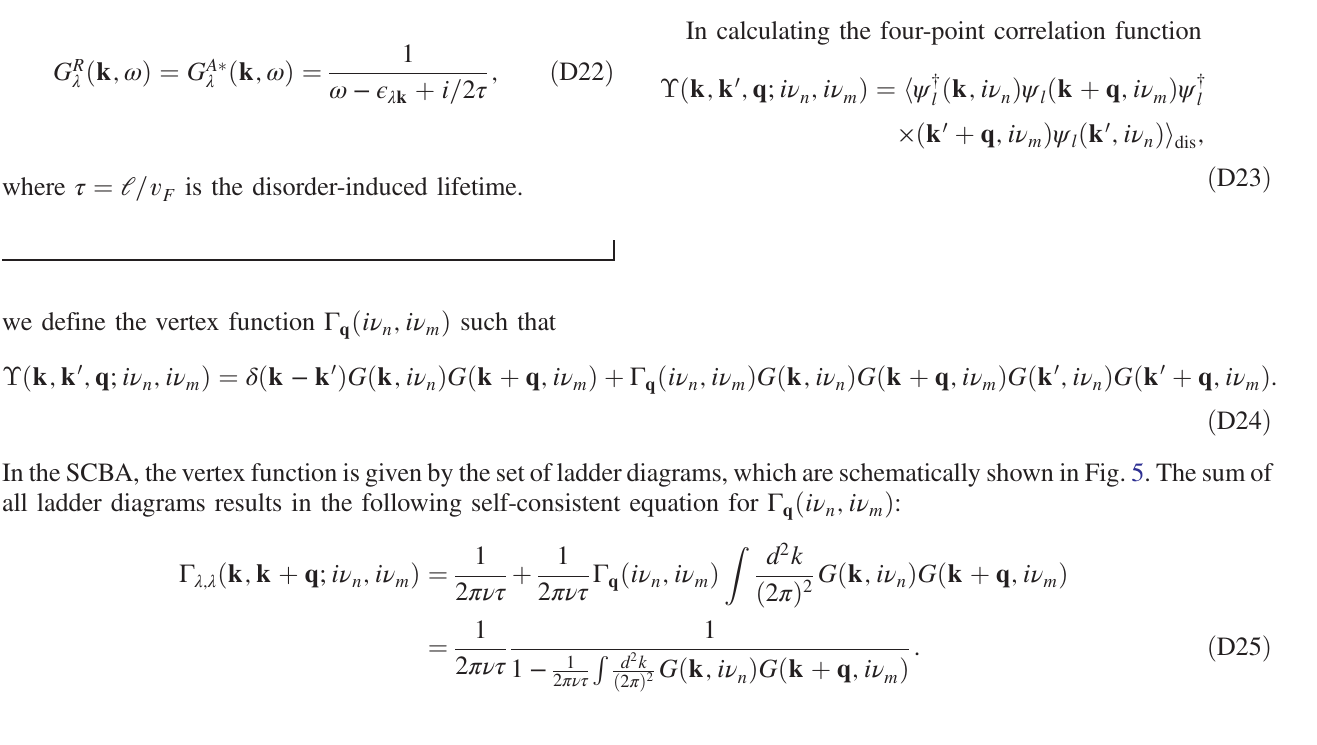
FIG. 5. In the self-consistent Born approximation, which is ≫ 1 , only ladder diagrams without crossed l valid when k F mfp disorder lines contribute to the vertex function. In this figure, the solid lines are renormalized electron propagators, and dashed lines represent the effects of